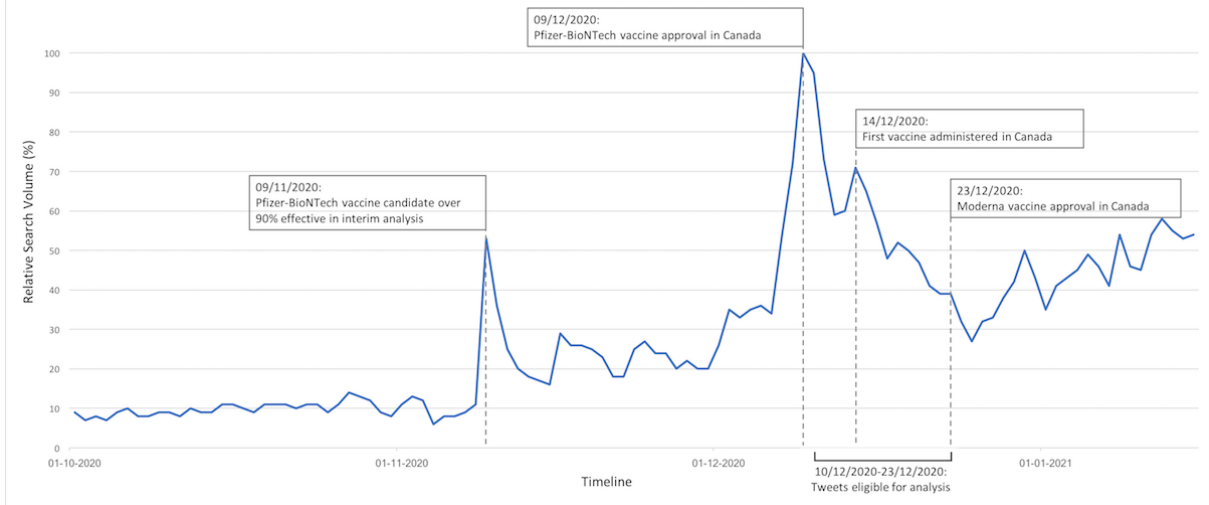
Figure 1. A graph depicting Google Trends data for the combined search terms “covid” and “vaccine” aligning with vaccine approval and administration dates in Canada. Tweets that were posted between December 10 and 23, 2020 were eligible for analysis. This date range aligned with the time when the highest peaks in related Google search activity occurred in Canada. This figure indicates that the number of searches on Google for the combined words “COVID” and “vaccine” was highest in December 9, 2020. All other searches were relative to this highest peak. For example, on December 14, 2020, roughly 70% of related searches occurred in December 9, 2020 [28]. It was not possible to obtain more detailed